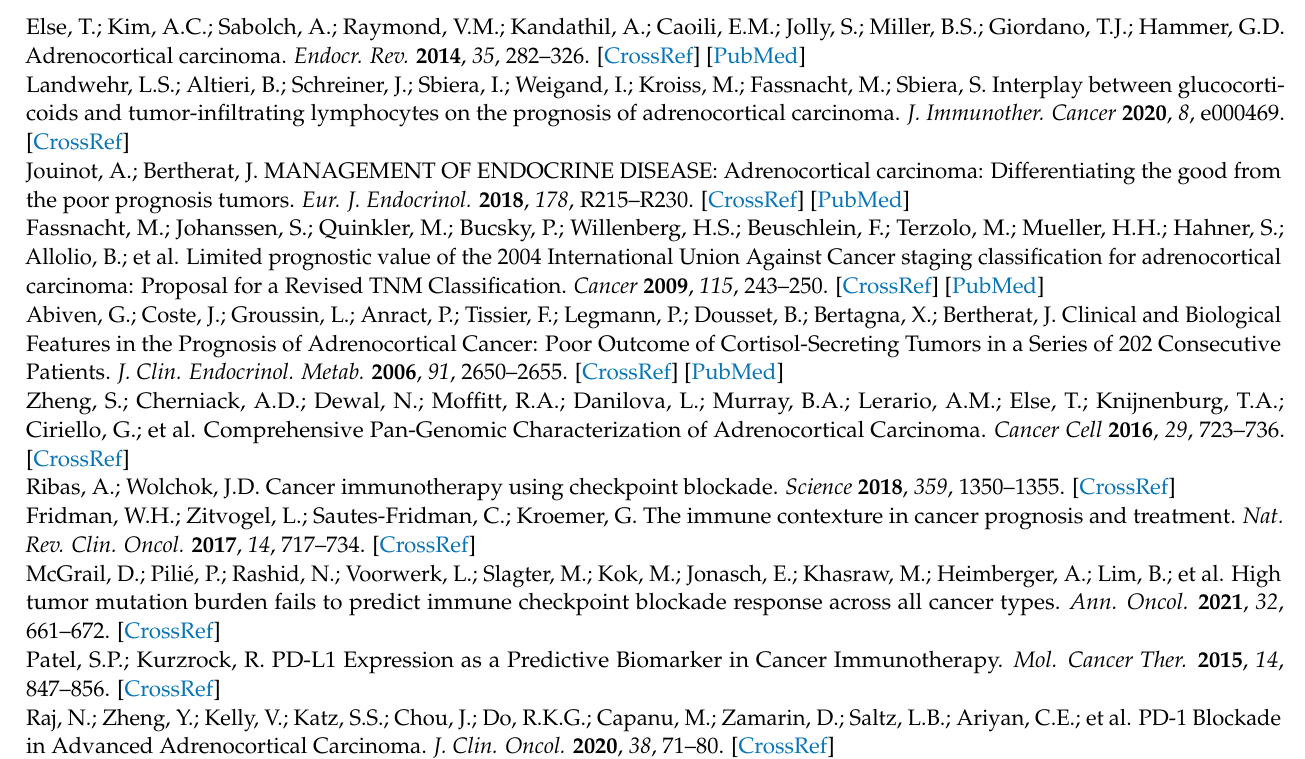
Table S2: The gene sets representing immune signatures, pathways, and biological